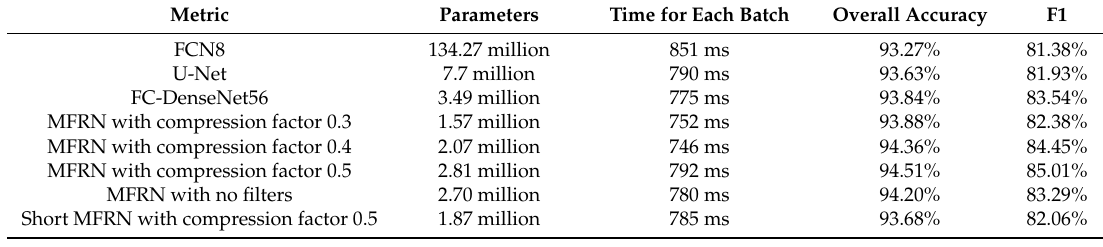
Table 2. Comparison results of different models.